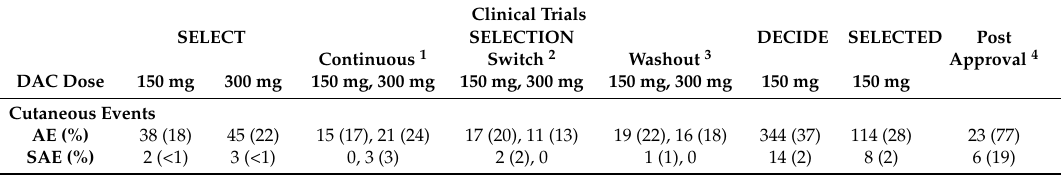
Table 3. Cutaneous AE Incidence for DAC treated patients in Controlled Trials of DAC HYP.